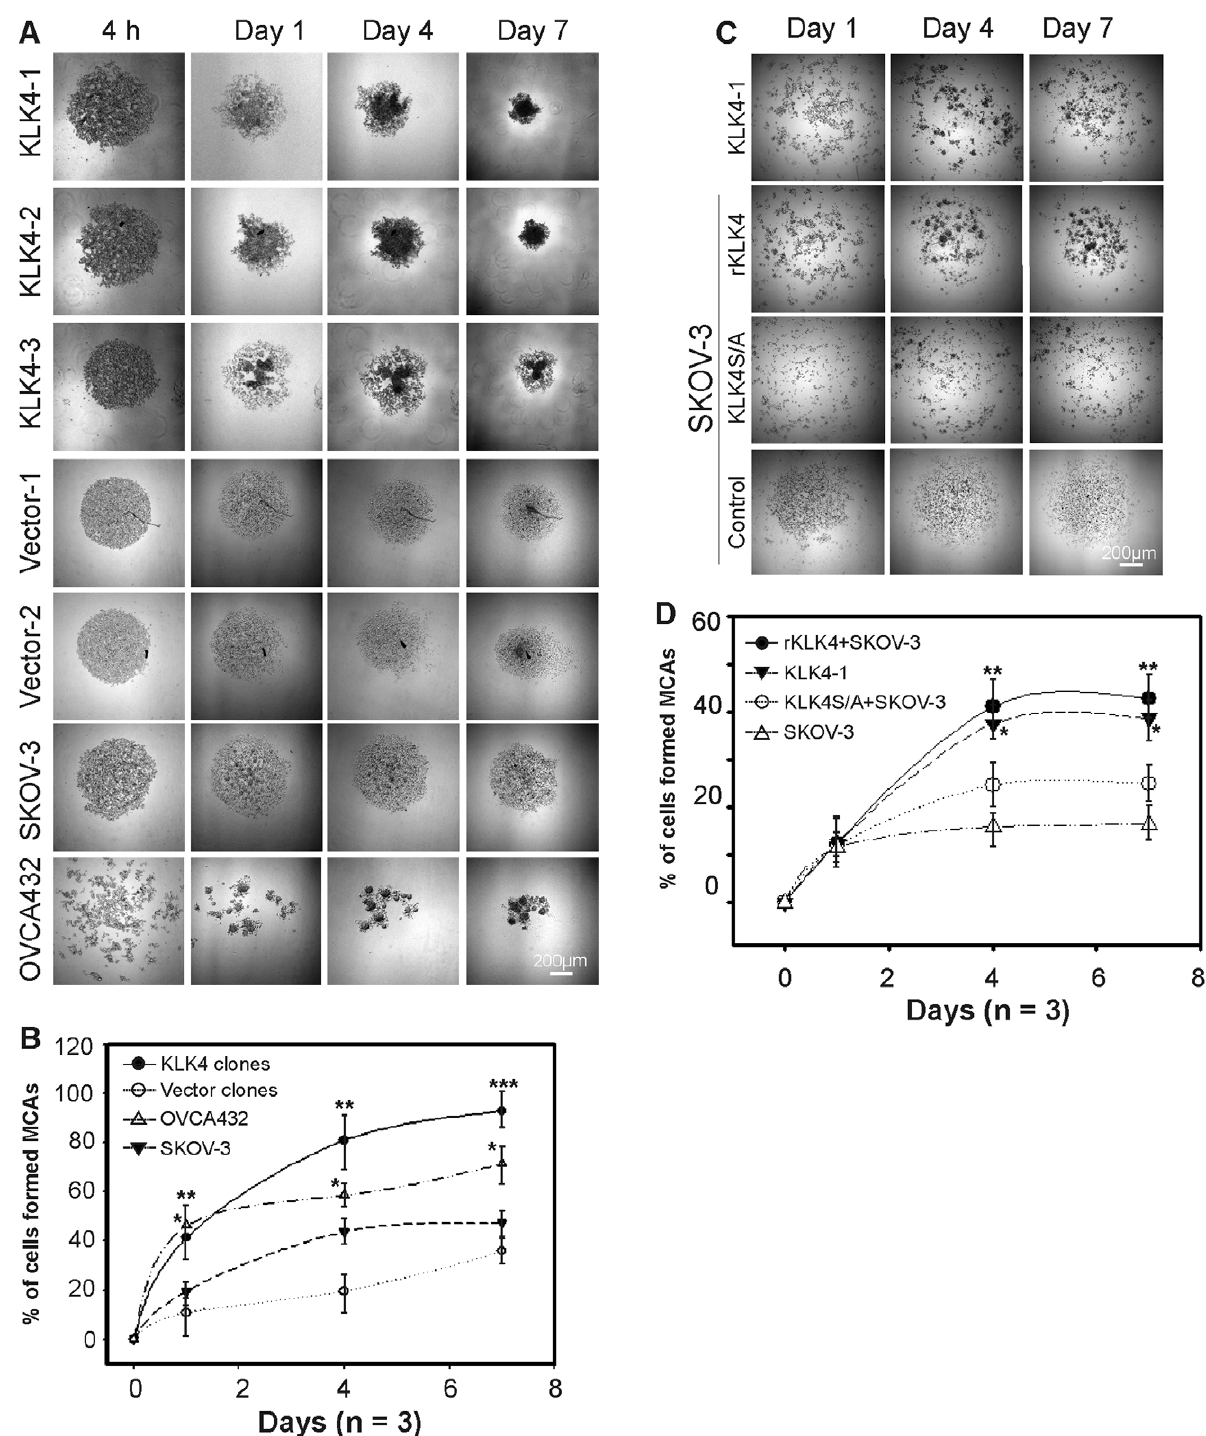
Figure 2. KLK4-expressing SKOV-3 cells form compact MCAs in a 3D-suspension microenvironment. A. MCA/spheroid formation conducted in 10% FCS containing media at 4 h, day 1, 4 and 7, with representative images of KLK4-1, KLK4-2, KLK4-3, Vec-1, Vec-2 clones, native SKOV-3 and endogenous KLK4 expressing OVCA432 cells. B. Quantitative analysis of percentage of 4 h (0 time point) that formed compact MCAs ( $ 30 m m) after 1, 4 and 7d from the 3 KLK4 clones combined, 2 vector clones combined, native SKOV-3 and OVCA432 cells. C. MCA formation under serum free conditions by KLK4-1 clone and native SKOV-3 cells treated with 50 ng/ml active recombinant (r)KLK4or mutant-KLK4S207A (KLK4S/A) and PBS control at day 1, 4 and 7. D. Quantitative analysis of compact MCA formation of KLK4-1, SKOV-3 treated with rKLK4, KLK4S/A and PBS as a control over 1, 4 and 7d. For panels A and C , scale bars, 200 m m; for B and D , the experiment was repeated 3 times with triplicates; mean 6 SEM; *P , 0.05; **P , 0.01; and ***P , 0.001.